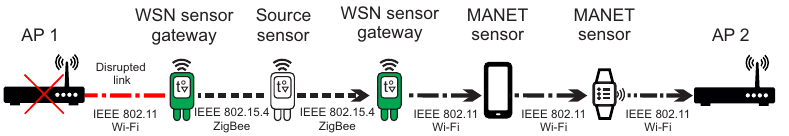
Figure 4. The example of communication between WSN sensor nodes, WSN gateway sensors and MANET layer